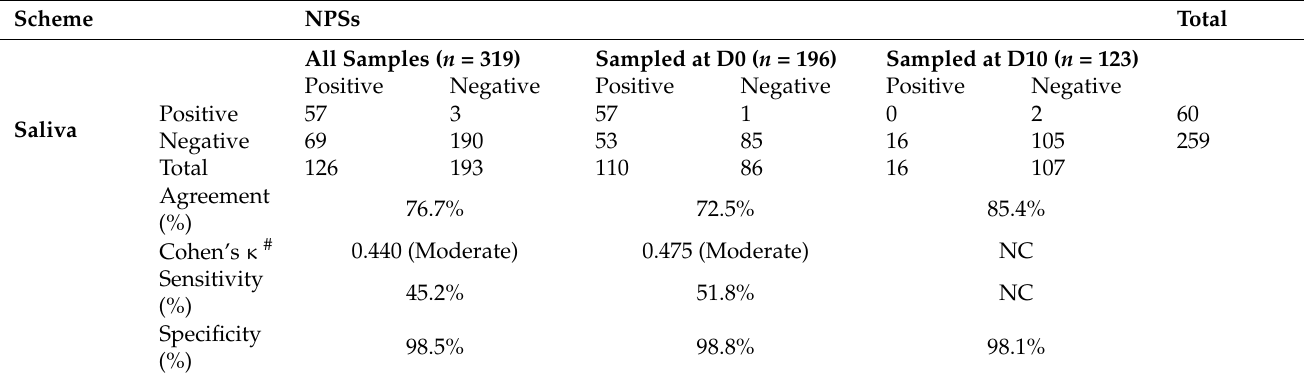
Table 2. Comparison of the RT-qPCR detection of SARS-CoV-2 between NPSs and saliva